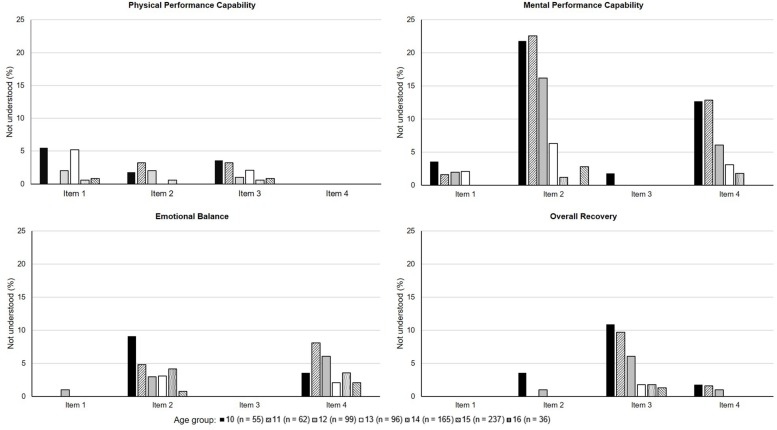
Percentages of items that were not understood within the Recovery dimension separated by age subgroups of phase 2.